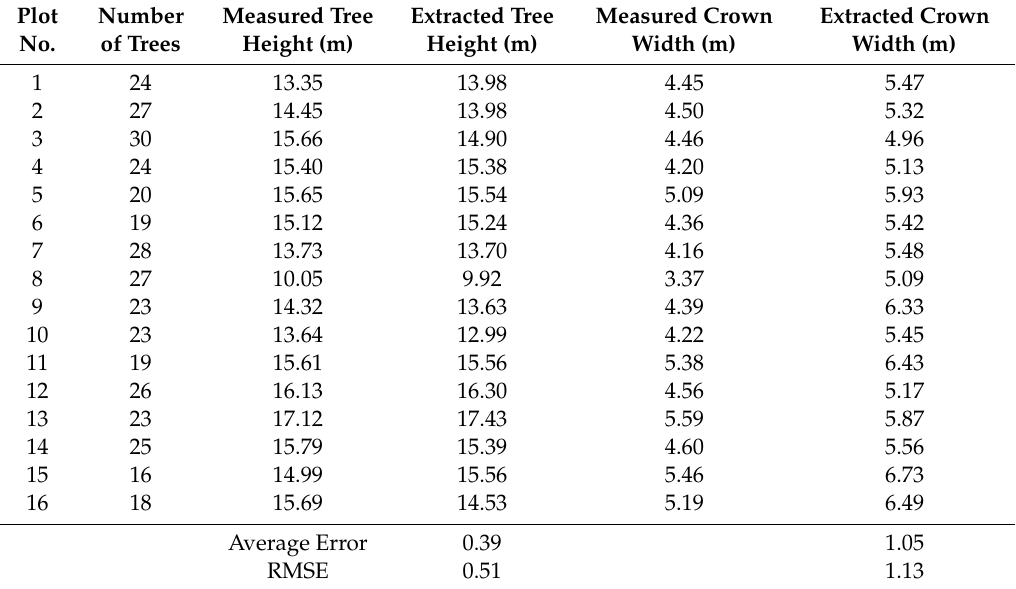
Table 6. The statistics of the tree extracted by watershed algorithm in 16 super plots. Plot